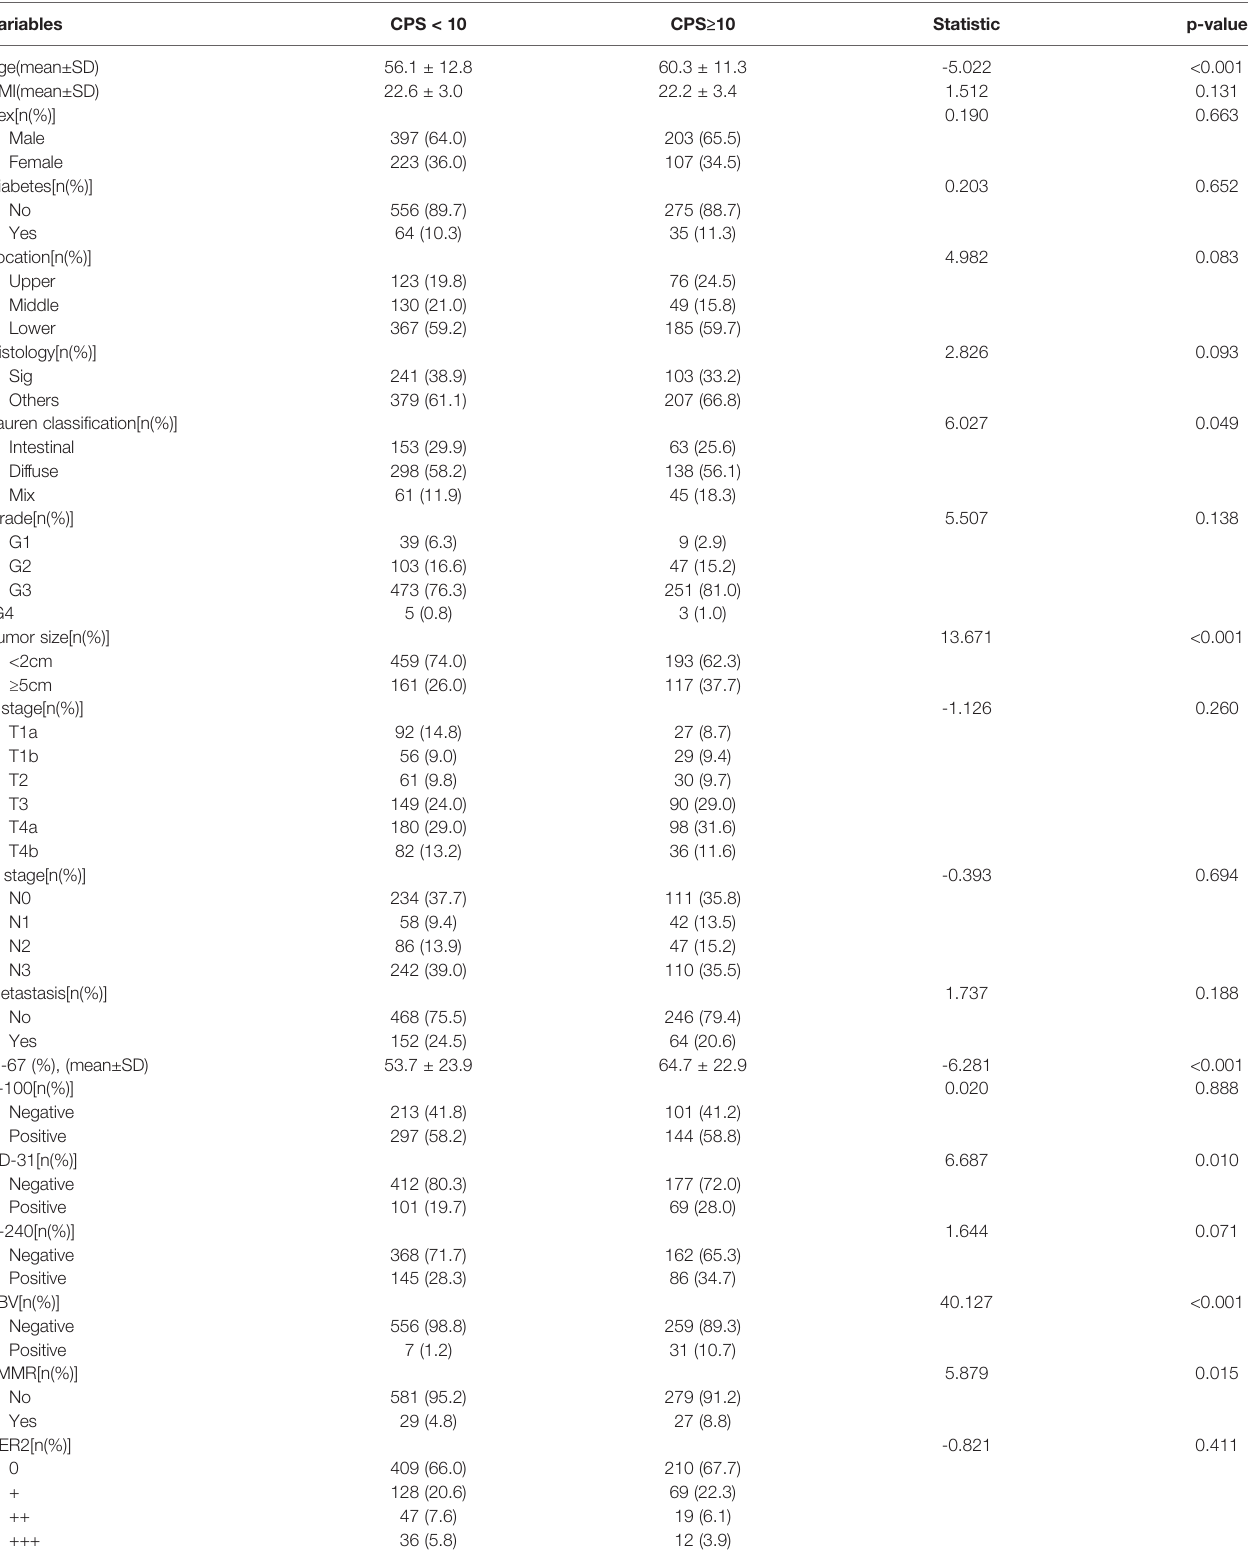
TABLE 5 | Clinicopathological features associated with PD-L1 expression of CPS ≥